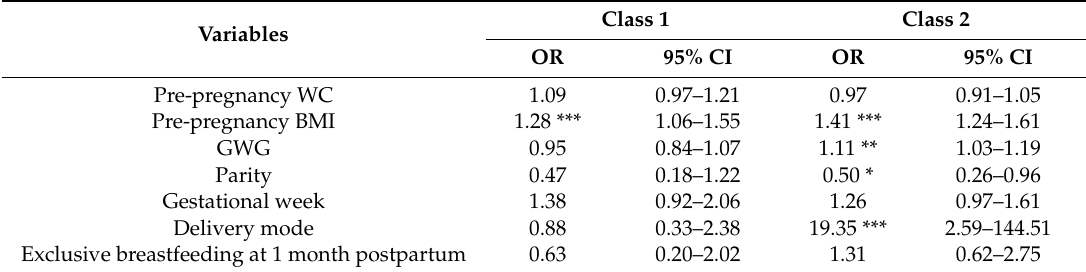
Table 6. Covariates prediction of trajectory class based on the post hoc logistic